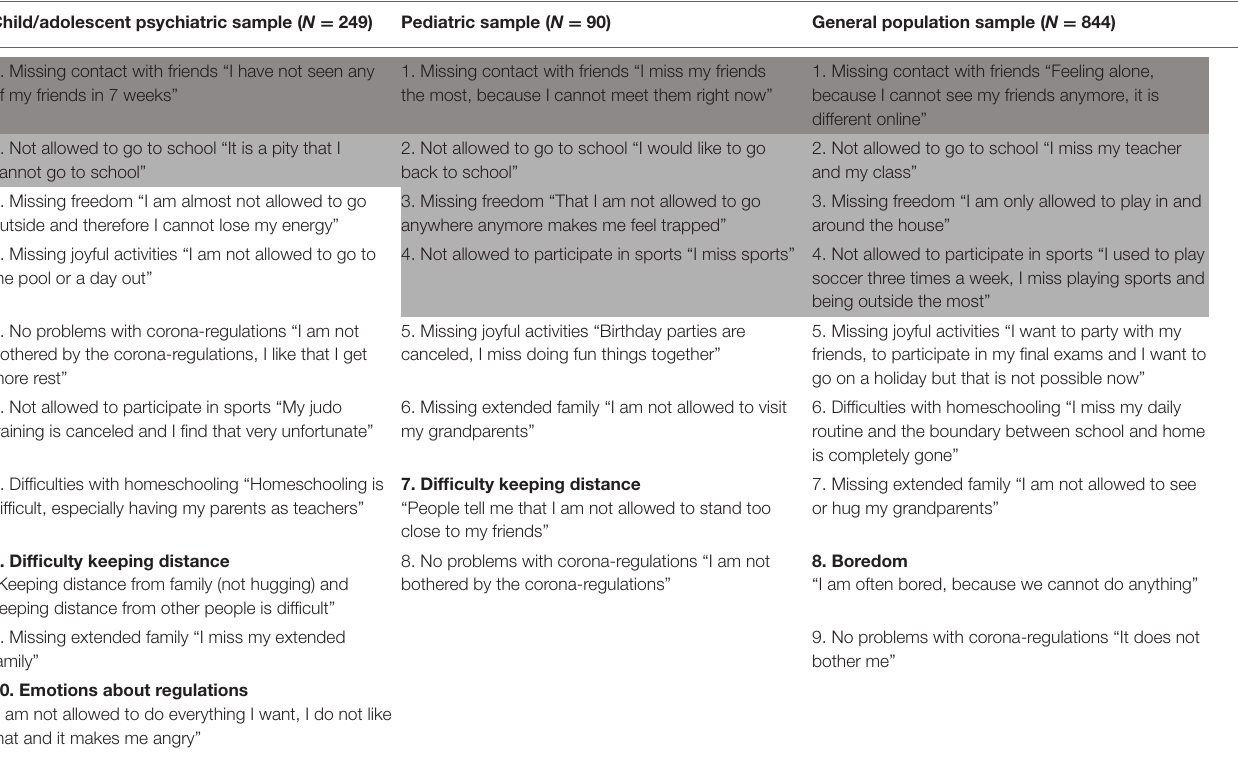
TABLE 5 | Overview of the most mentioned themes ( ≥ 5% of the children per sample) in response to the open question “How are the corona-regulations for you?” per sample, ranked by the number of times mentioned (most to least). Child/adolescent psychiatric sample ( N =